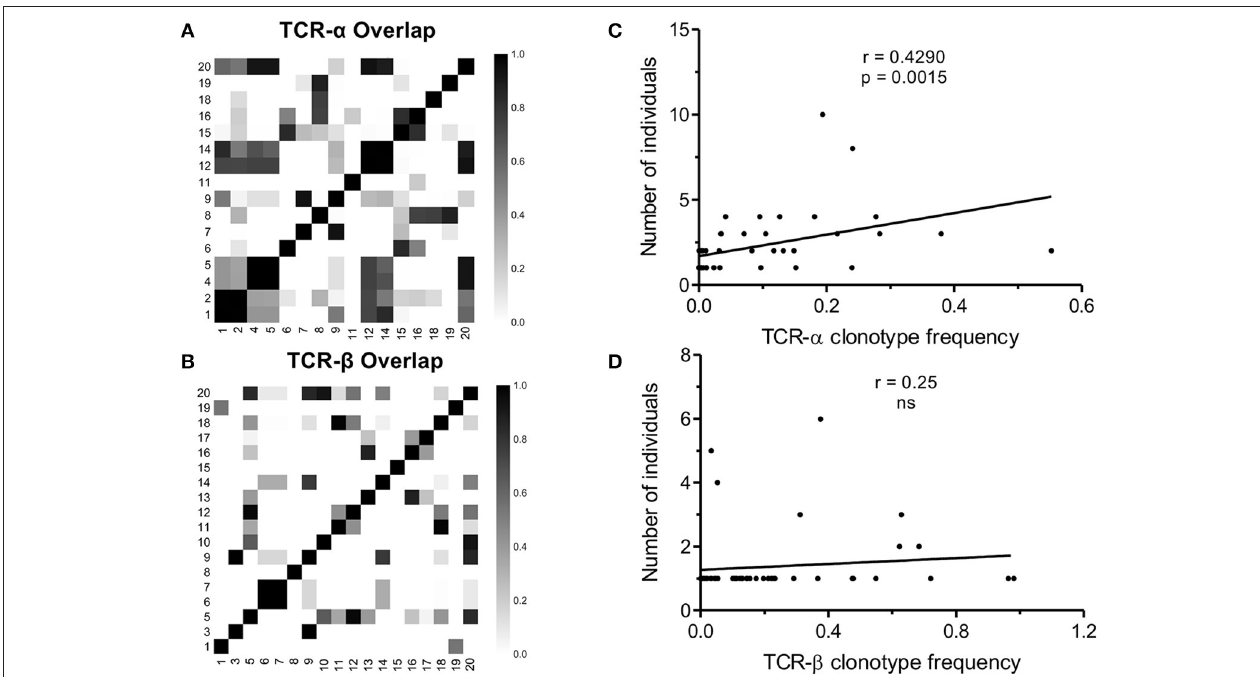
FIGURE 4 | TCR sharing amongst NW8-specific CD8 + T cells from CMV-infected individuals. Compositional similarity amongst (A) TCR- α and (B) TCR- β chains was assessed using the Morisita-Horn (C MH ) index and illustrated as a heat map. Patient numbers are shown along the x and y-axes. C MH values range from 0 (no overlap) to 1 (perfect overlap). The average frequency of a given clonotype is plotted against the number of individuals sharing that clonotype, for (C) TCR- α chains ( n = 53) and (D) TCR- β chains ( n = 51). Spearman’s rho and p -values are shown above each